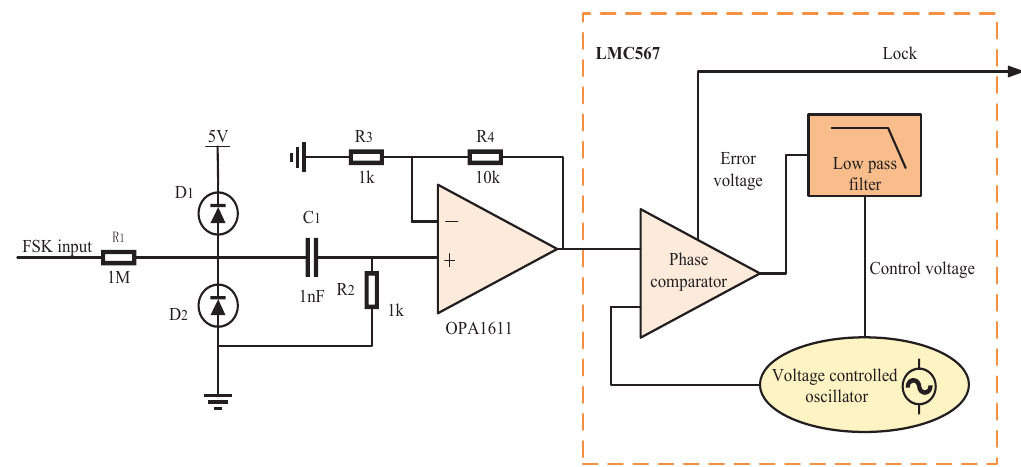
Figure 4. Schematic diagram of data